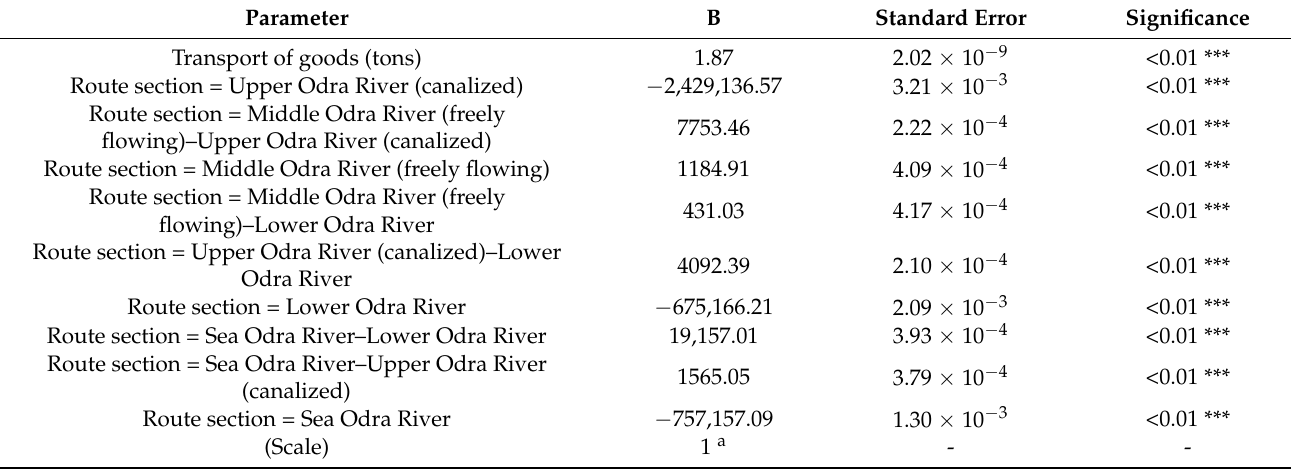
Table 7. Model of energy consumption in inland waterway freight transport in relation to the selection of the route section and the volume of